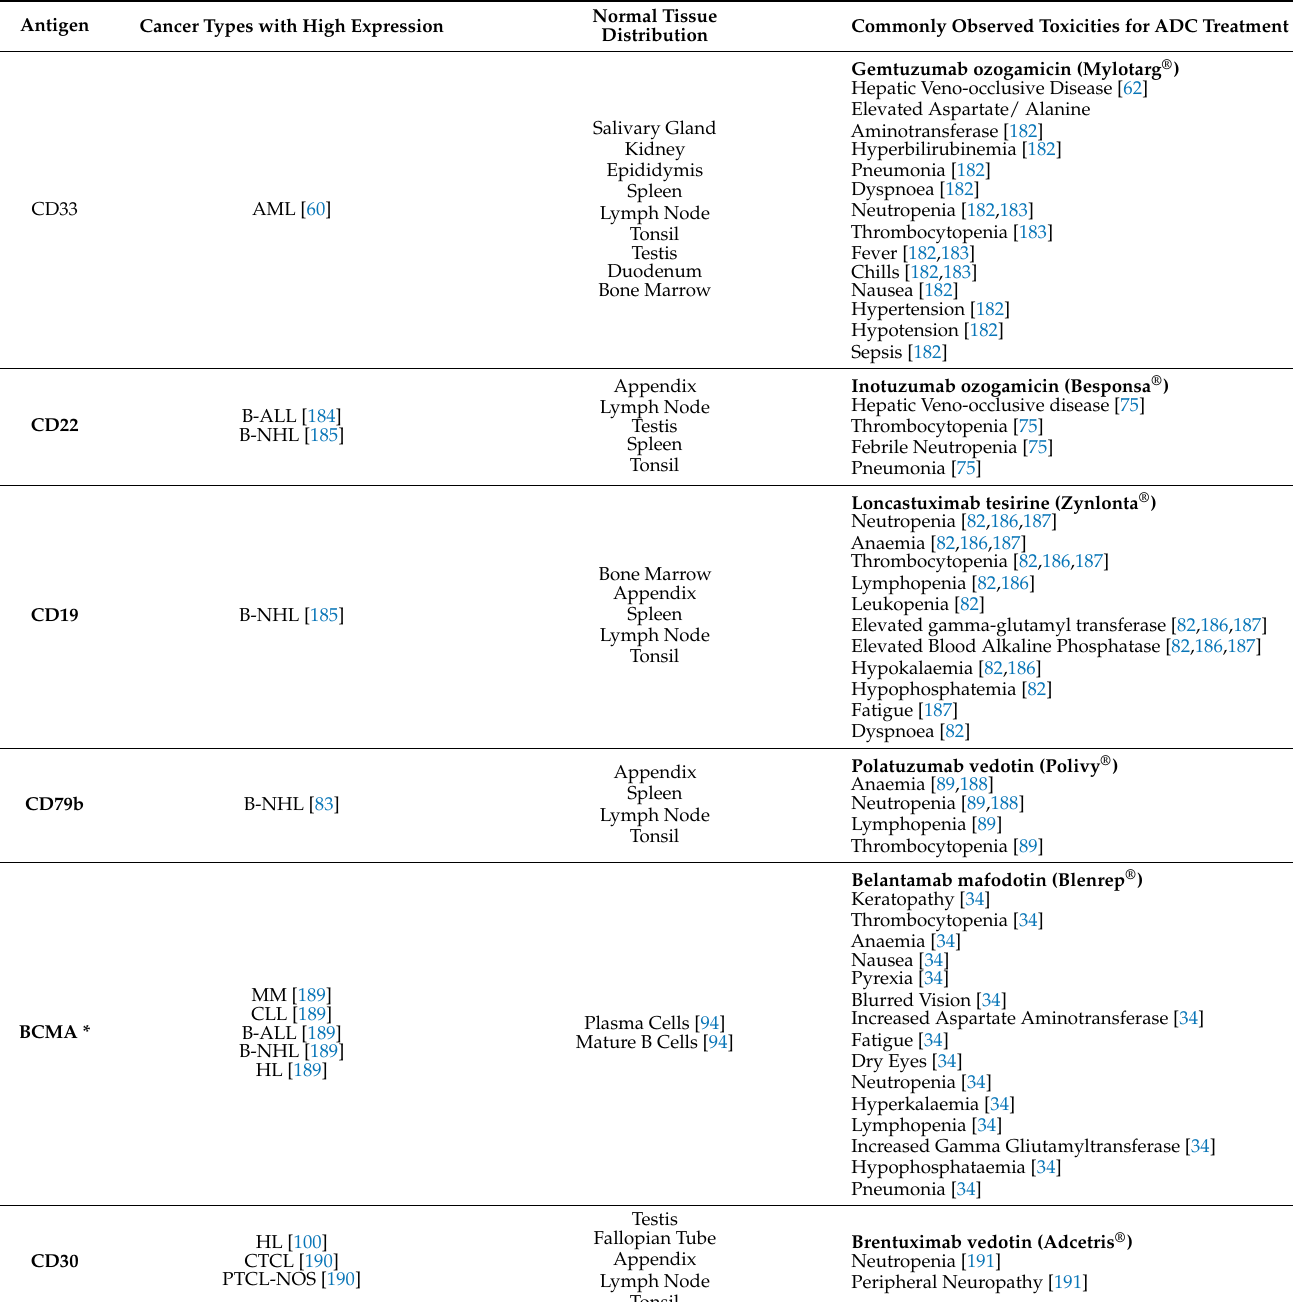
Table 4. Tissue Distribution of Target Antigens and Associated Toxicities. with